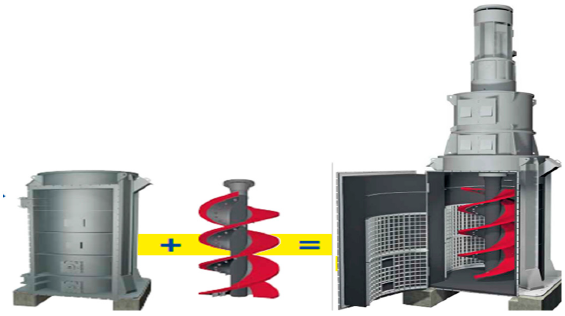
Figure 1. Vertical stirred mill components [24].